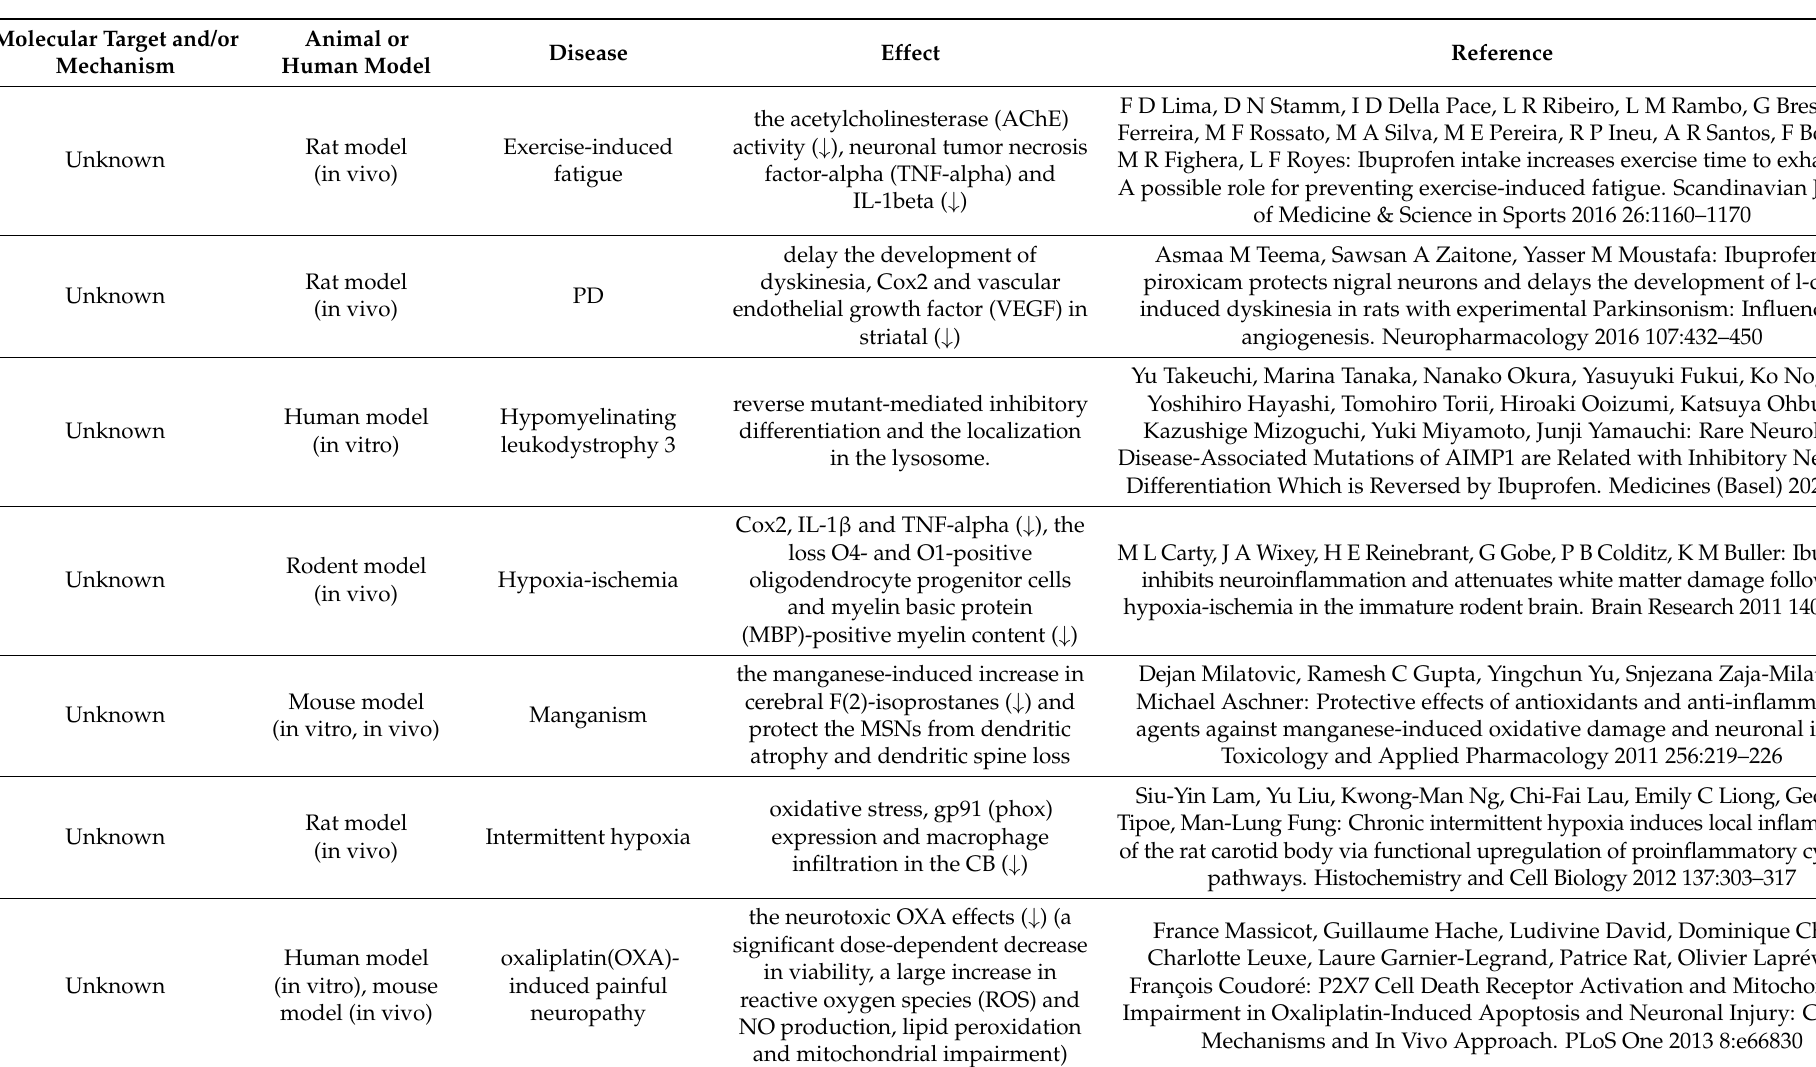
M R Fighera, L F Royes: Ibuprofen intake increases exercise time to exhaustion: A possible role for preventing exercise-induced fatigue. Scandinavian Journal of Medicine & Science in Sports 2016